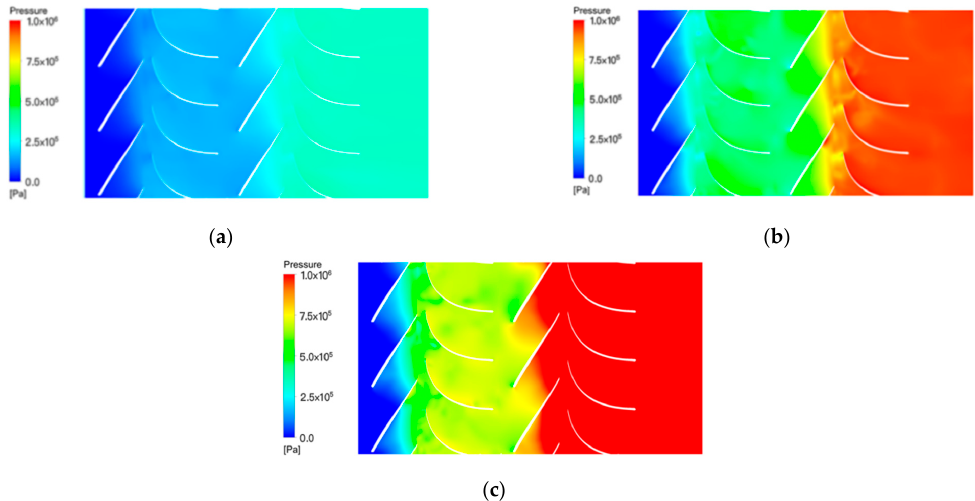
Figure 19. Pressure distribution on first-stage impeller-guide vane B2B view: ( a ) n = 900 r/min; ( b ) n = 1450 r/min; ( c ) n = 1800 r/min.